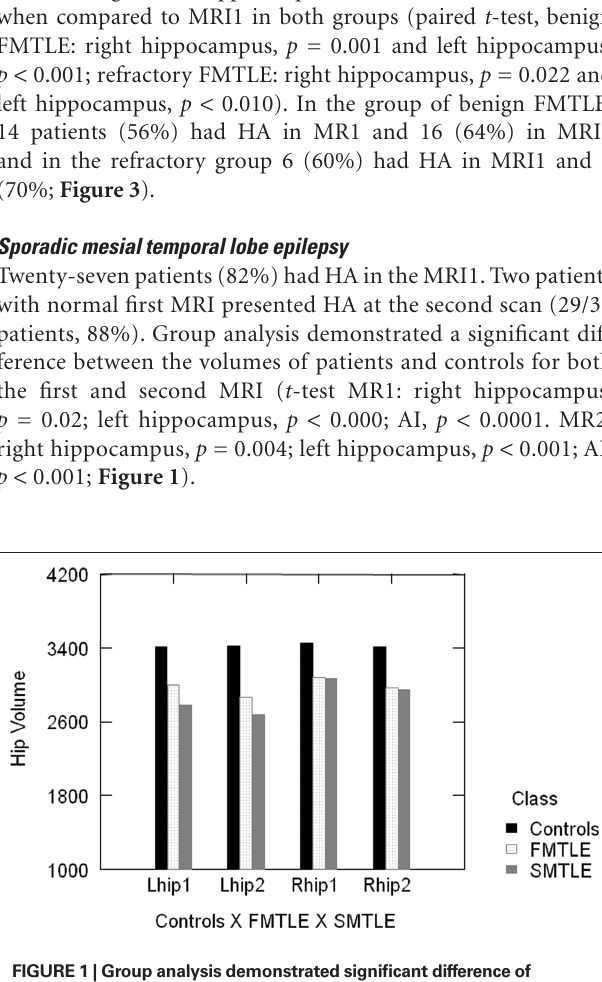
FIguRe 1 | group analysis demonstrated significant difference of hippocampal volumes of controls and patients (FMTLe and SMTLe) for both the first and second MRI. Lhip1, left hippocampus in the first MRI; Lhip2, left hippocampus in the second MRI; Rhip1, right hippocampus in the first MRI; Rhip2, right hippocampus in the second